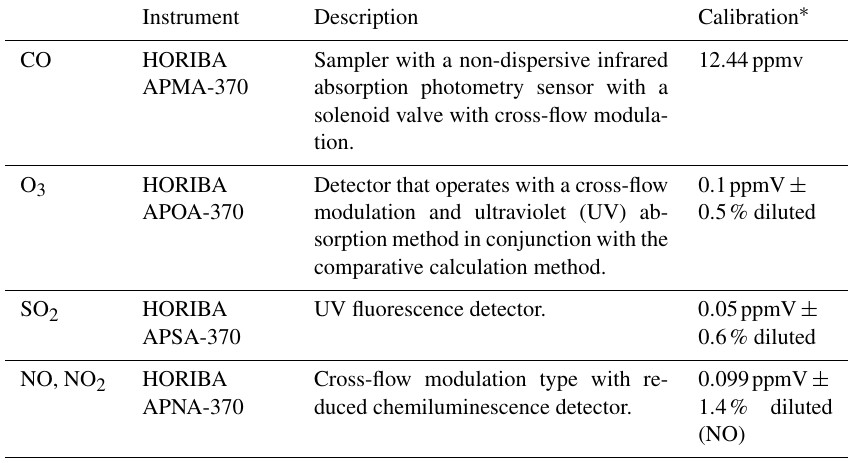
Table 2. Description of the equipment used at the CNEA site. Instrument Description CO HORIBA Sampler with a non-dispersive infrared APMA-370 absorption photometry sensor with a solenoid valve with cross-flow modula- tion. Detector that operates with a cross-flow APOA-370 modulation and ultraviolet (UV) ab- sorption method in conjunction with the comparative calculation method. UV fluorescence detector. Cross-flow modulation type with re- duced chemiluminescence